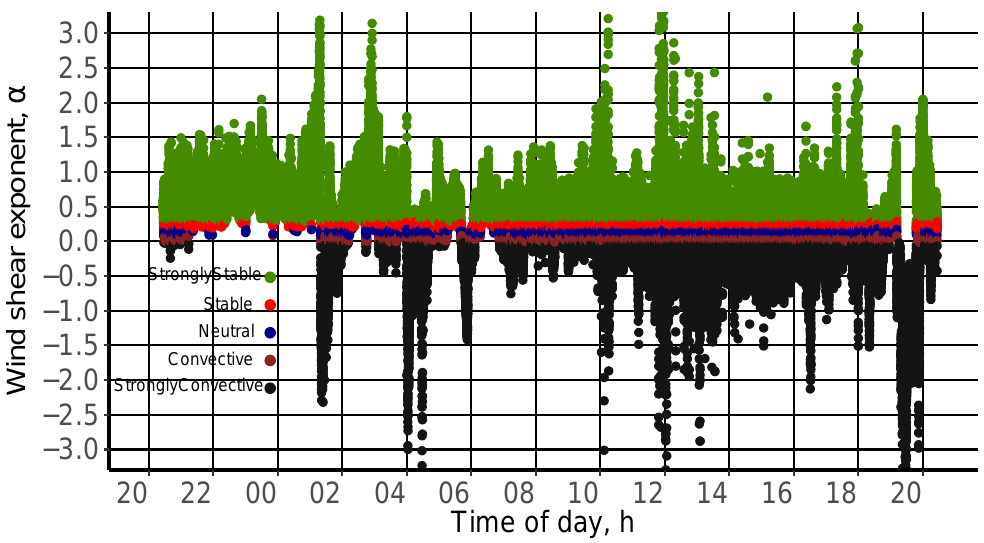
Figure 5. Wind shear variation with time of day at La Ventosa, Oaxaca, Mexico. Period presented from 09 to 10 october of 2017.